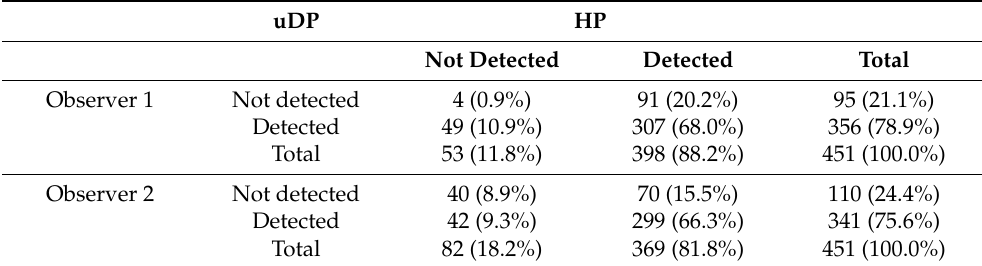
Table 1. Contingency table for the detection of metastatic lesions in unenhanced and dynamic phase (uDP) vs. hepatobiliary phase (HP) images by